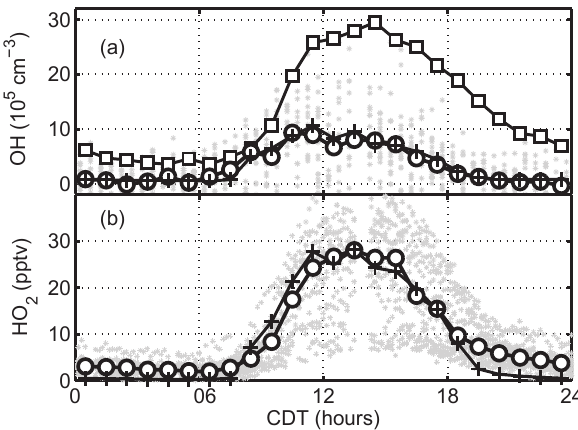
Figure 1. Diel variation of measured and modeled OH / HO 2 dur- ing SOAS (Feiner et al., 2016). In panel (a) , measured OH by a tra- ditional laser-induced fluorescence technique is shown in squares and by a new chemical scavenger method is shown in circles. The latter one is considered as the “true” ambient OH. Simulated OH from a photochemical box model with Master Chemical Mecha- nism (MCM) v3.3.1 is shown in pluses. In panel (b) , measured HO 2 is shown in circles and modeled HO 2 is shown in pluses. For both panels, gray dots are individual 10min